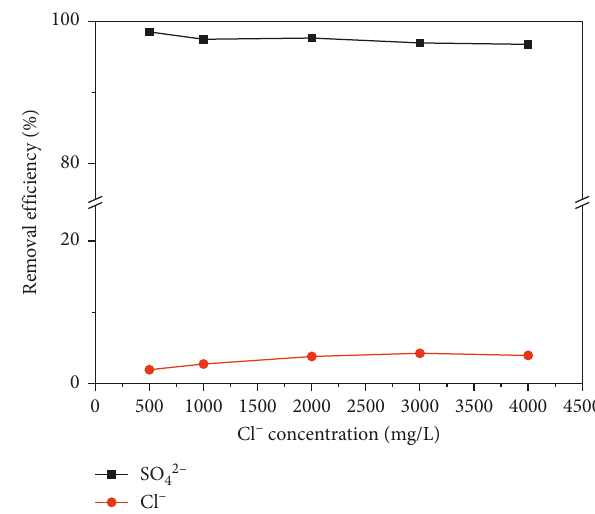
solution (cid:27) 1L, t (cid:27) 30min,